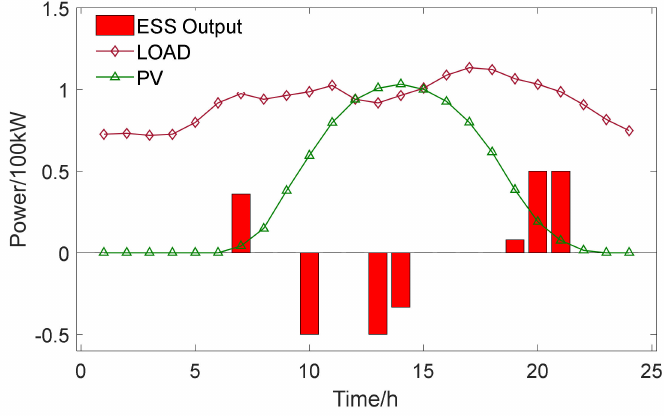
Figure 9. The tenth node load, PV, and storage output